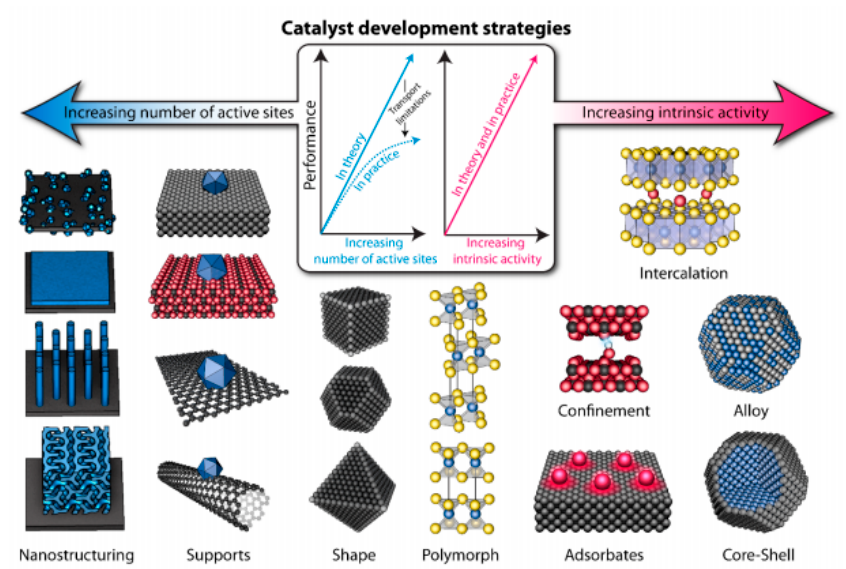
Figure 9. Catalyst development strategies. Schematic of various catalyst development strategies, aim to increase the number of active sites and / or increase the intrinsic activity of each active which aim to increase the number of active sites and/or increase the intrinsic activity of each active site.